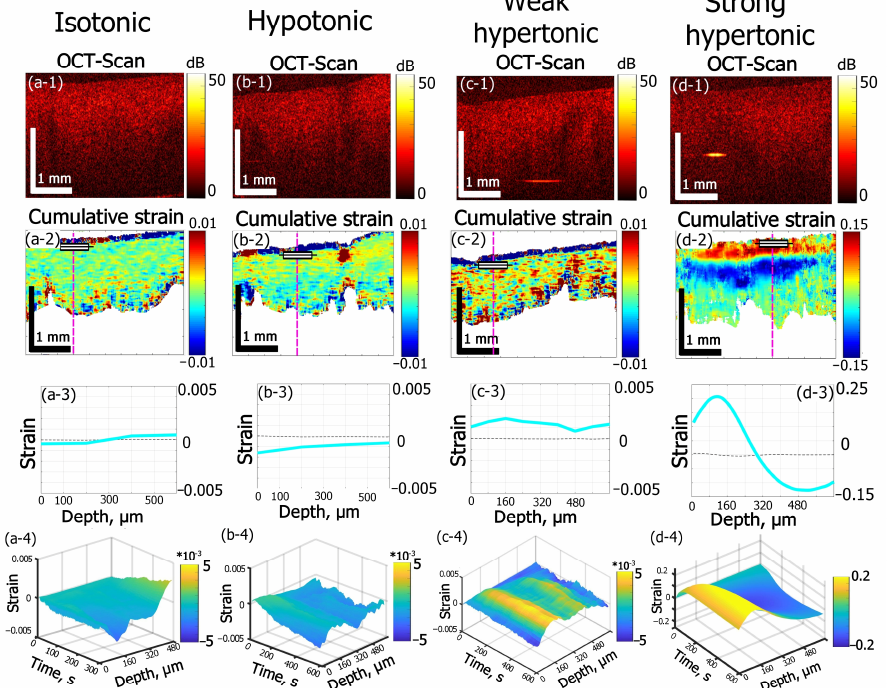
Figure 2. Effects of solutions of different osmolarity on strain kinetics and amplitude inside cartilage samples. The row numbers from 1 to 4 correspond to the following images: (1) structural OCT scans; (2) the corresponding cumulative-strain in-depth maps, (3) strain distribution along the dashed lines in the images in row (2); (4) “waterfall” diagrams of strain dynamics along dashed lines in (2). The columns from ( a – d ) correspond to: ( a ) saline solution (0.9% NaCl, 300 mOsm) applied to cartilage samples in the native state, time of observation 300 s; ( b ) saline solution (0.9% NaCl, 300 mOsm) applied to cartilage samples preliminarily saturated with 50% glycerol, time of observation 600 s; ( c ) 7% aqueous weakly hypertonic glycerol solution, time of observation 600 s; ( d ) 35% strongly hypertonic aqueous glycerol solution, time of observation 600 s. Notice that for row 3 showing the depth profiles for the cumulative strain, the depth is counted from the rectangular markings shown in the images in row 2.